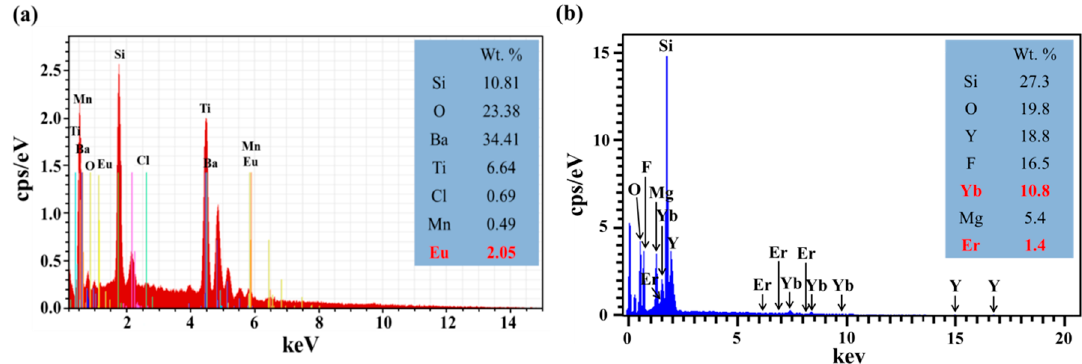
Figure 4. EDS spectra from silicon substrate coated with layer of SiO 2 containing ( a ) Eu-doped silicate phosphors and ( b ) Yb/Er-doped Y 2 O 3 phosphors.